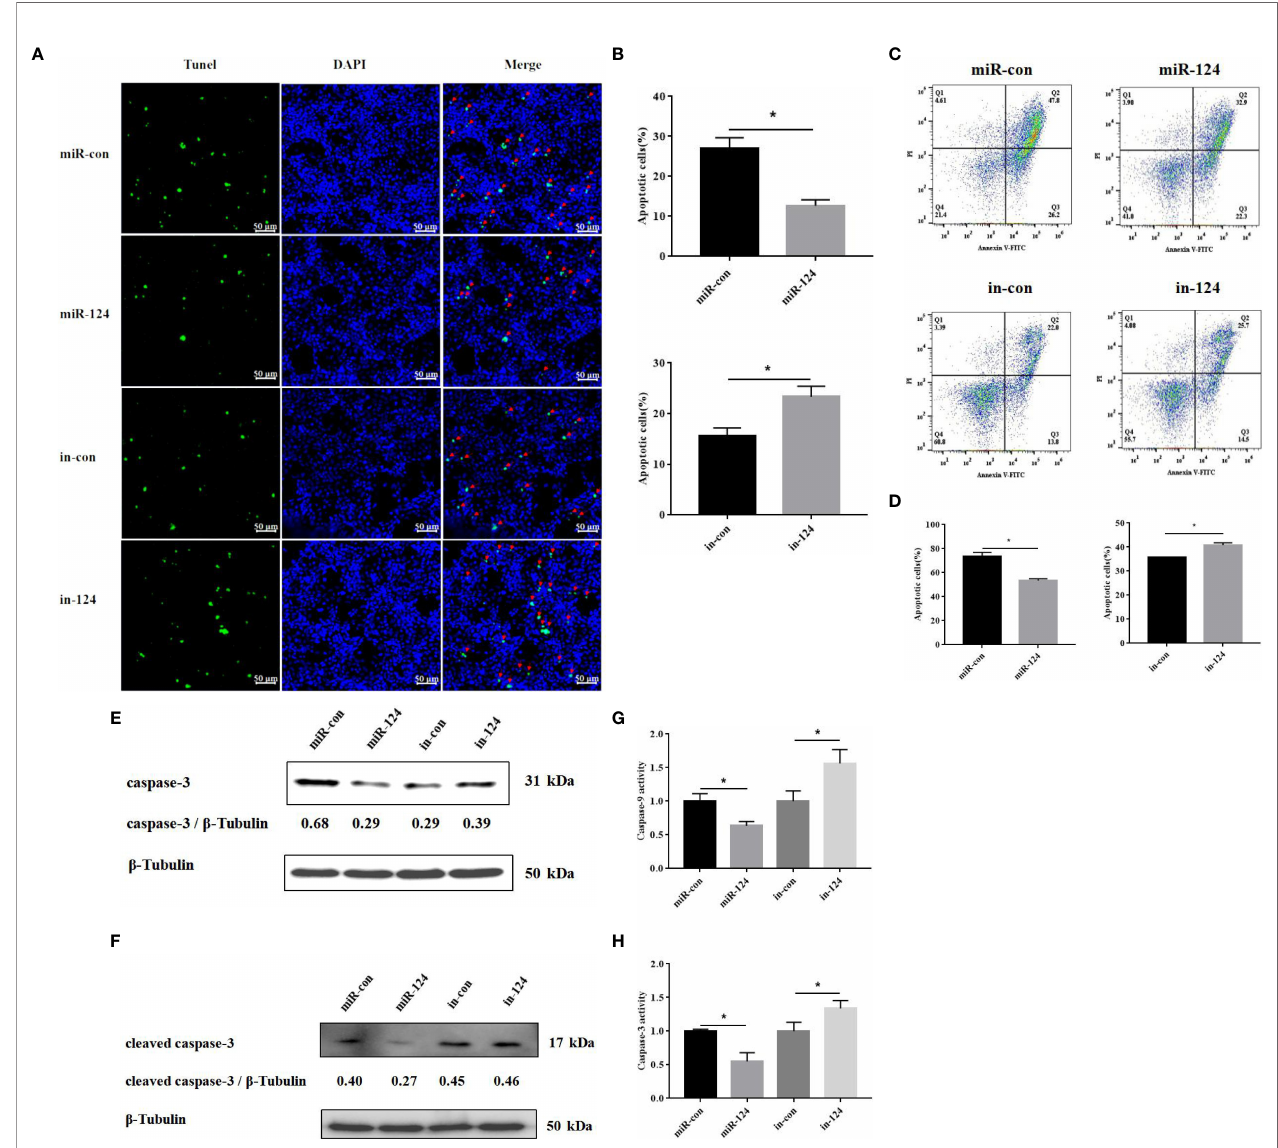
FIGURE 8 | The effect of miR-124 on apoptosis of fathead minnow (FHM) cells. (A) Detection of apoptosis by TUNEL assay. The green fl uorescent markers indicate fractured DNA fragments, and the blue fl uorescent markers represent the nucleus. The red arrows indicate the fractured DNA fragments. Scale bars represent 50 m m. (B) Comparison of apoptosis rates of FHM cells in different groups. (C) Singapore grouper iridovirus (SGIV)-induced apoptotic bodies in FHM cells. Q1: PI+, Annexin − . Q2: PI+, Annexin+. Q3: PI − , Annexin+. Q4: PI − , Annexin − . Q2 and Q3 represent the percentage of late apoptosis and early apoptosis, respectively. (D) The graph is based on the average of three parallel experimental data. (E, F) The level of caspase-3 and cleaved caspase-3 proteins was detected by Western blotting, the band intensity was calculated, and ratios of target protein/ b -tubulin were assessed by ImageJ software. (G, H) The activity of caspase-9 and caspase-3 after SGIV infection. Control mimics, miR-con; miR-124 mimics, miR-124; control inhibitors, in-con; miR- 124 inhibitors, in-124. All data are presented as mean ± SD, N = 3. Compared with the control group, signi fi cant difference of experimental group is indicated with *( P <